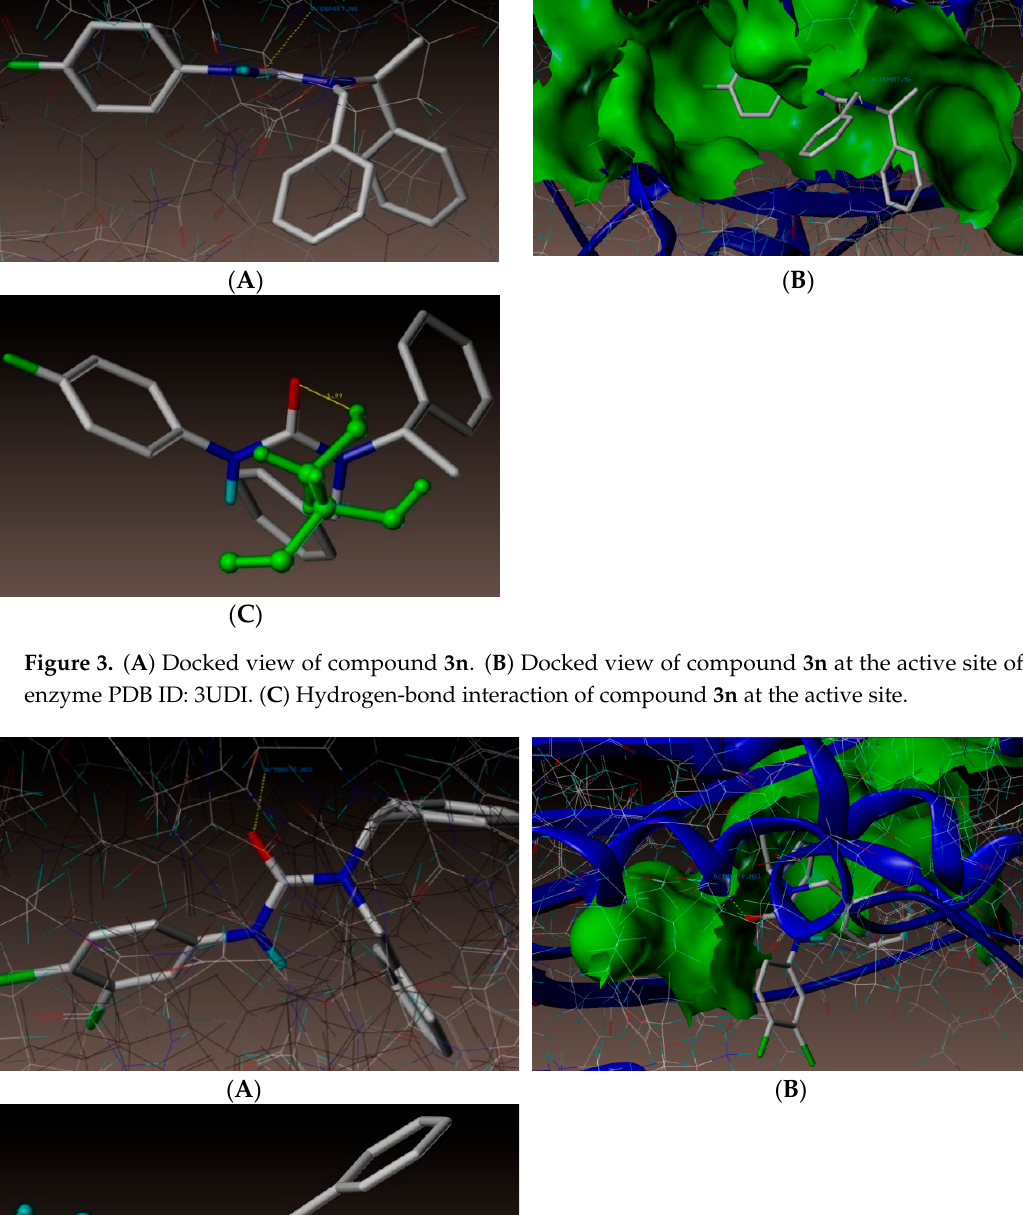
Figure 2. ( A ) All compounds docked into the active site of enoyl-(acyl-carrier-protein) reductase (ENR). ( B ) Docked view of all the compounds at the active site of enzyme PDB ID: 3UDI.